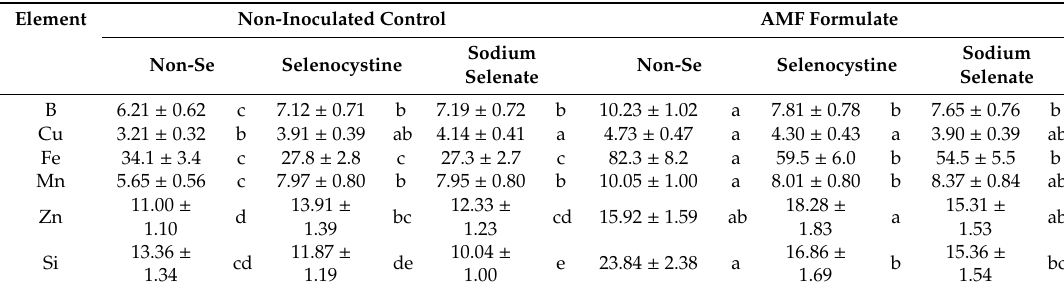
Table 6. Interaction between microorganism inoculation and selenium treatment on shallot bulb micro-elemental composition (mg · kg − 1 d.w.).